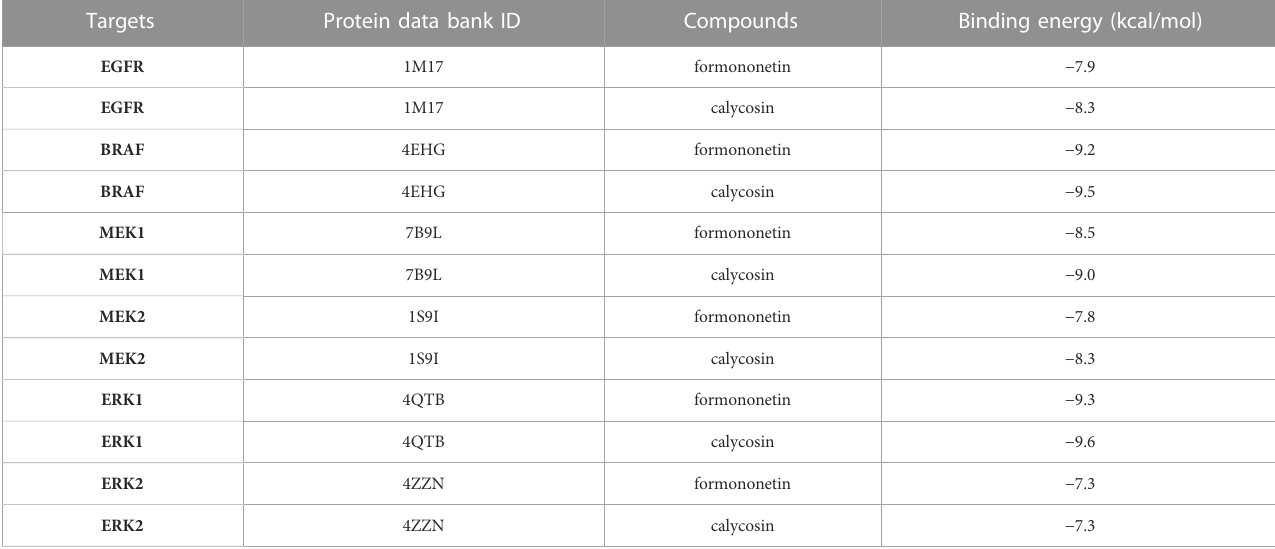
TABLE 1 Molecular docking of FMNT and CS and corresponding targets.